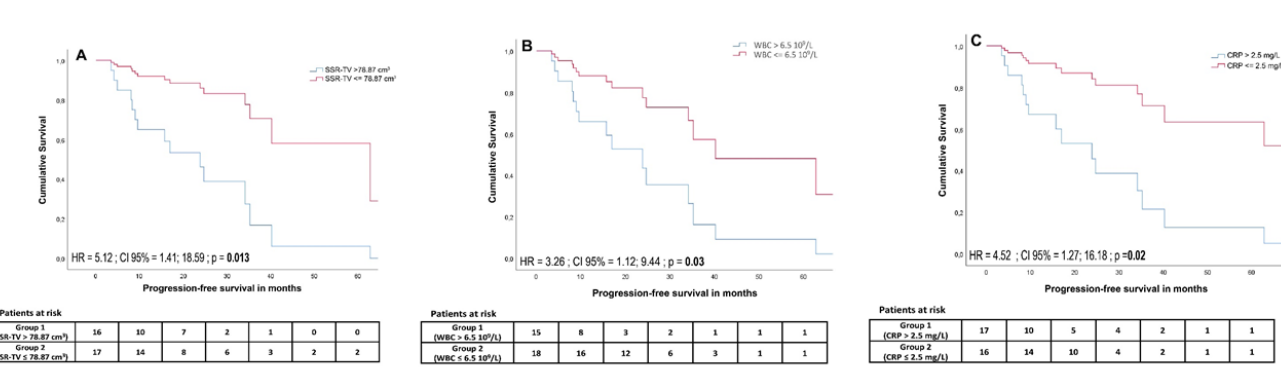
Table 3. Predictors of progression-free survival.